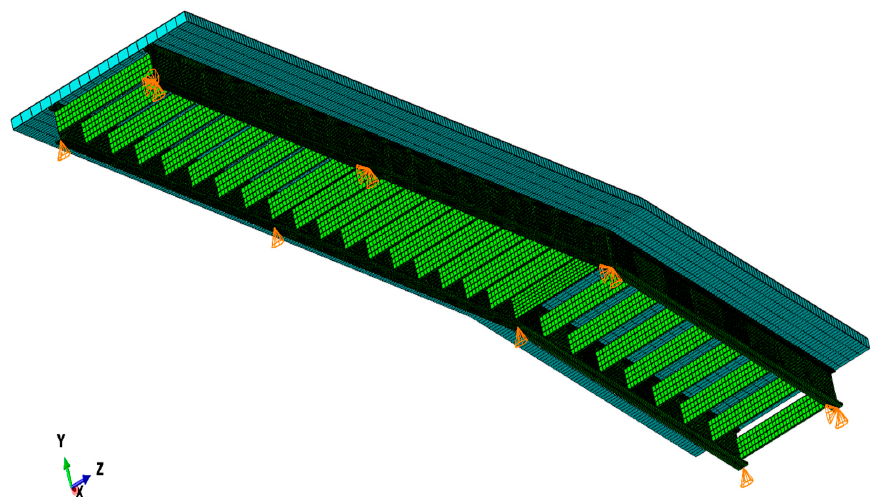
Figure 5. The FE model of the three-span continuous beam footbridge.